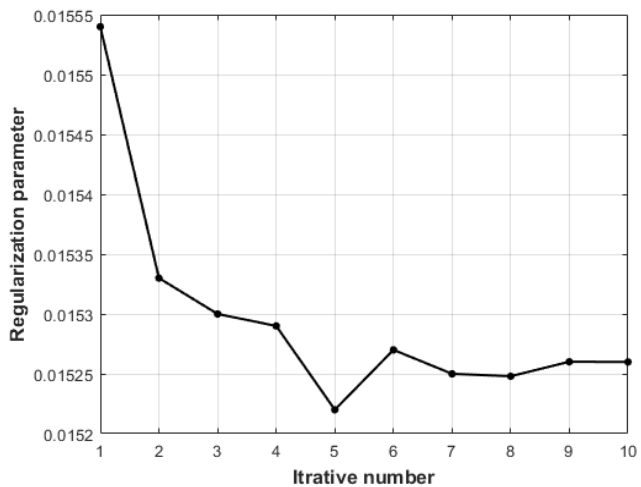
Figure 18. The regularization parameters with the number of iterations. Table 6. Parameter estimation and accuracy.